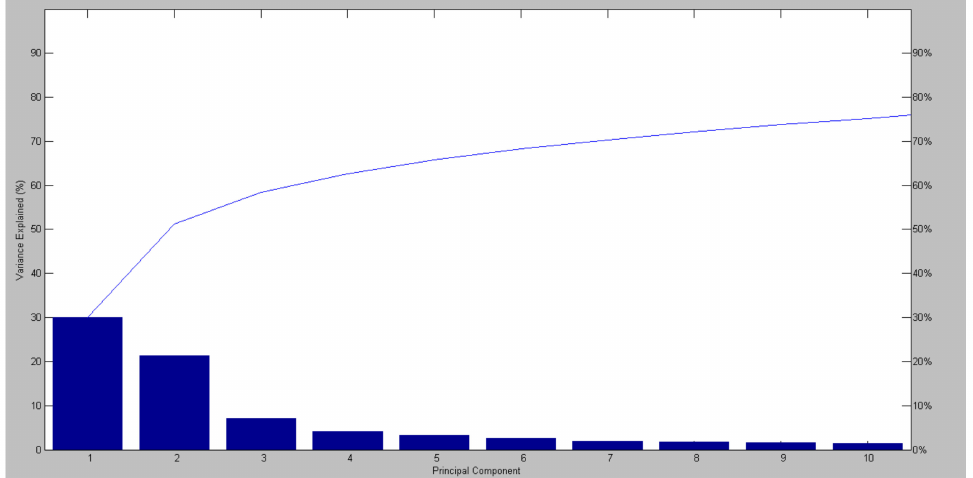
Figure 7. Variance explained from Maldi Biotyper PCA Clustering analysis of infected and healthy C. sinensis leaves samples. y -axis indicates the variance explained and x -axis indicates the principal